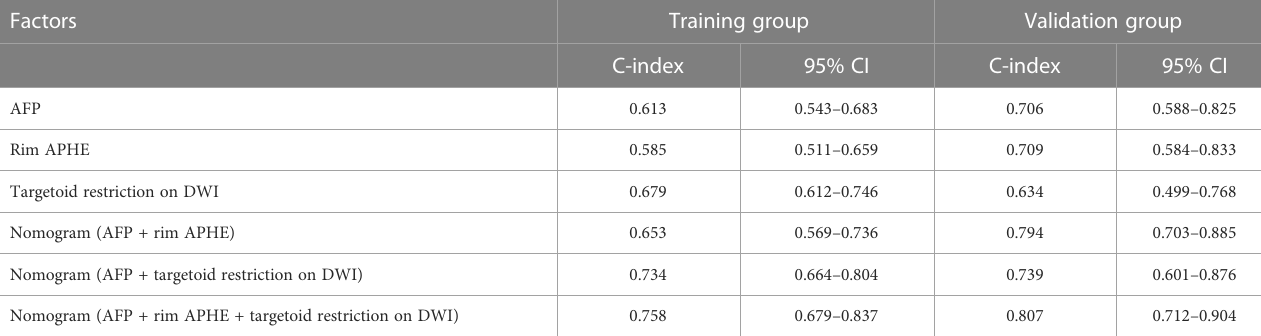
TABLE 3 Prediction performance of nomogram and independent risk factors in training and validation